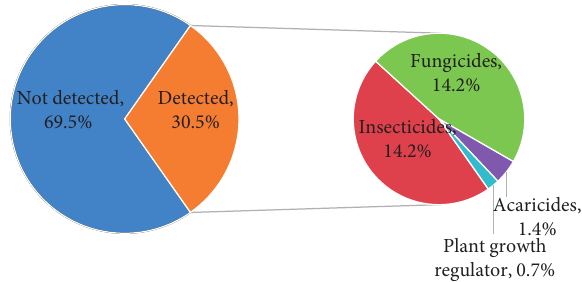
Figure 1: Detection ratio of different types of pesticides in Den- drobium officinale